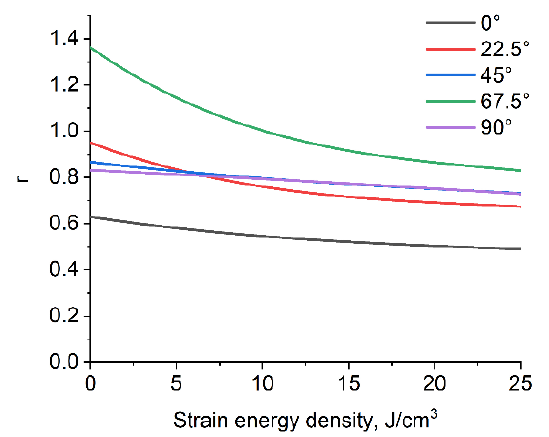
Figure 2. Fitted true stress–true strain curves for different directions.